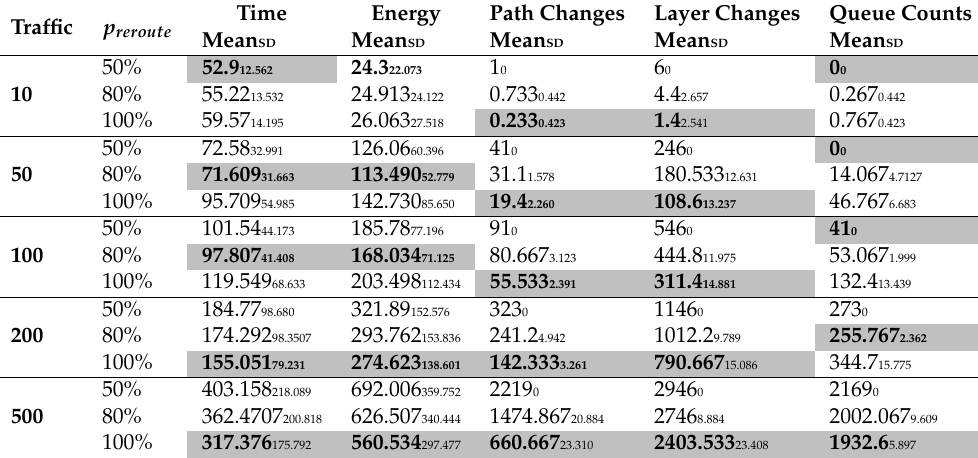
Table 2. Impact on traffic performance from varying p reroute in Global Probabilistic Dynamic (GPD) (50%, 80%,